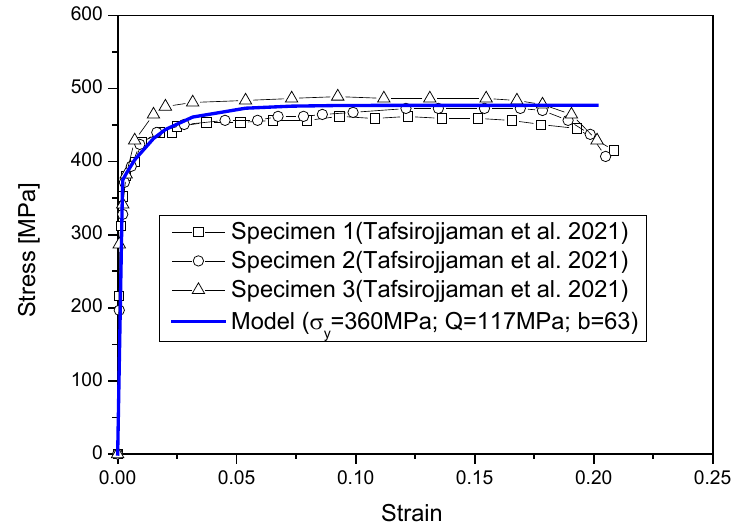
Figure 1. Stress-strain curves for steel [2].